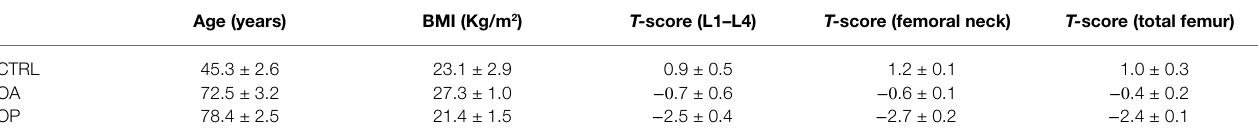
TABLE 1 | Main characteristics of CTRL, OA, and OP